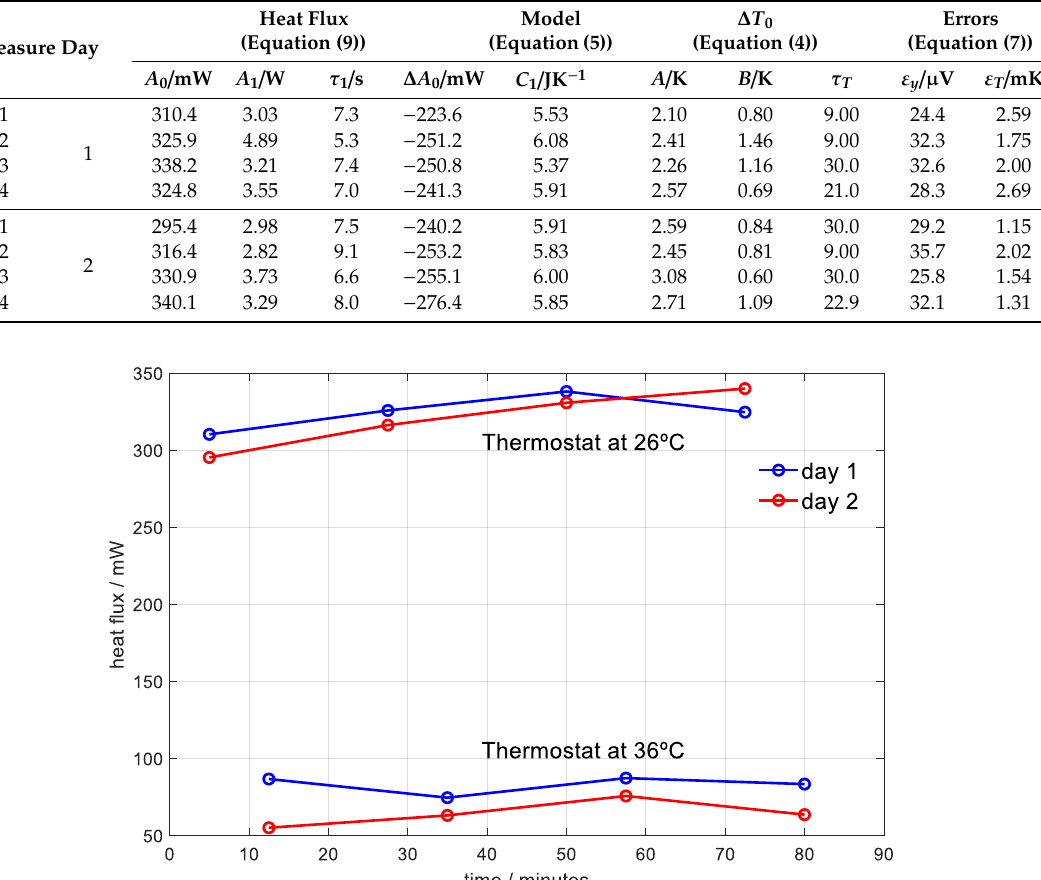
Figure 13. Heat flux transmitted from the temple to the sensor thermostat on different days and for different thermostat temperatures. Senior subject.